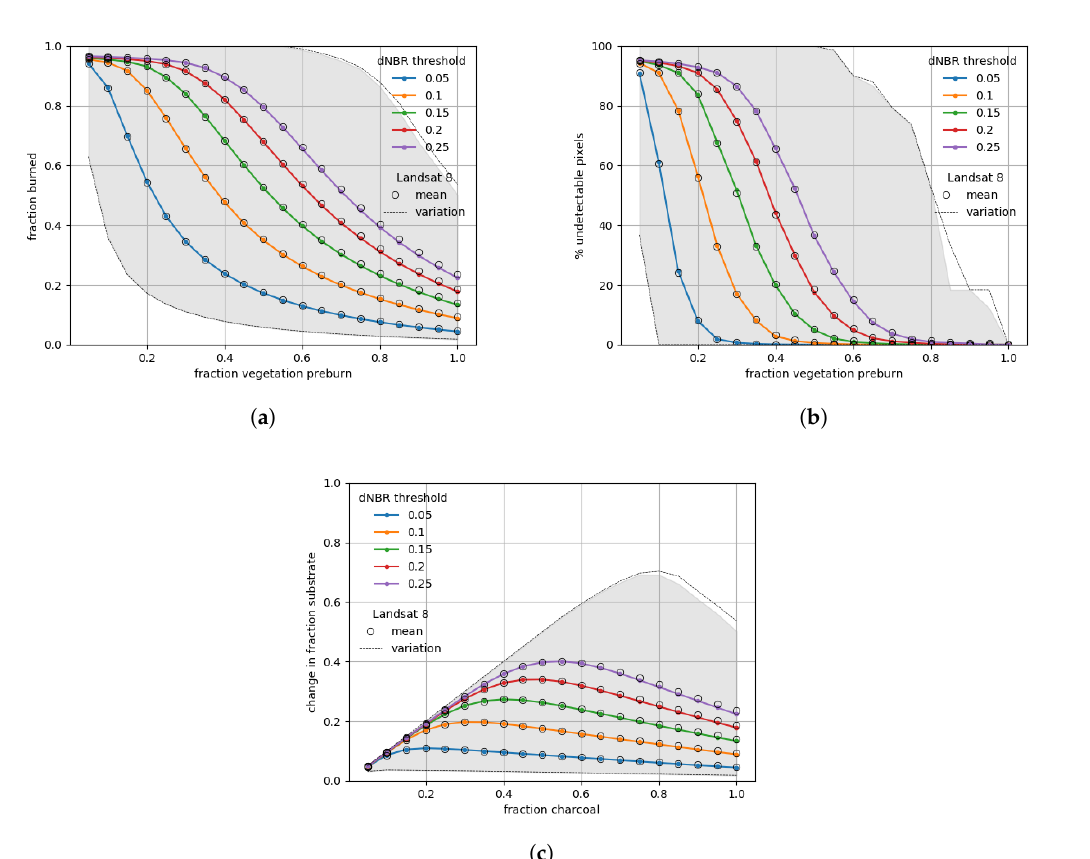
Figure A12. Park-wide detectability results for a pure burn scenario (where loss of vegetation fraction results in equal increase in charcoal fraction ( ∆ char = 1), for the Moderate Resolution Imaging Spectroradiometer (MODIS). The mean values are shown in colored lines, with total model result variation shown in gray. To compare, the results for Landsat 8 are shown in black, with mean values shown by circles and total model result variation shown by dashed lines. ( a ) Fraction of vegetation burned at detection. ( b ) Percentage of undetectable pixels. ( c ) Charcoal contribution on